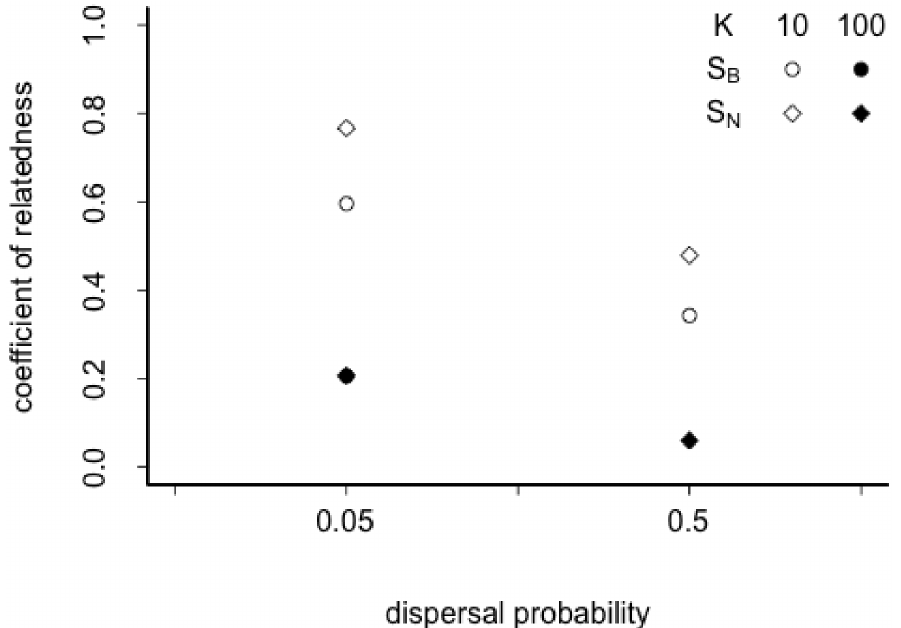
Fig 3. The effect of patch size (K), dispersal probability and dispersal strategy (S B , S N ) on coefficient of relatedness after 20 generations. Different strategies S B and S N are represented by circles and diamond symbols, respectively. Small patch sizes ( K = 10) are depicted with open symbols and big patch sizes ( K = 100) with filled